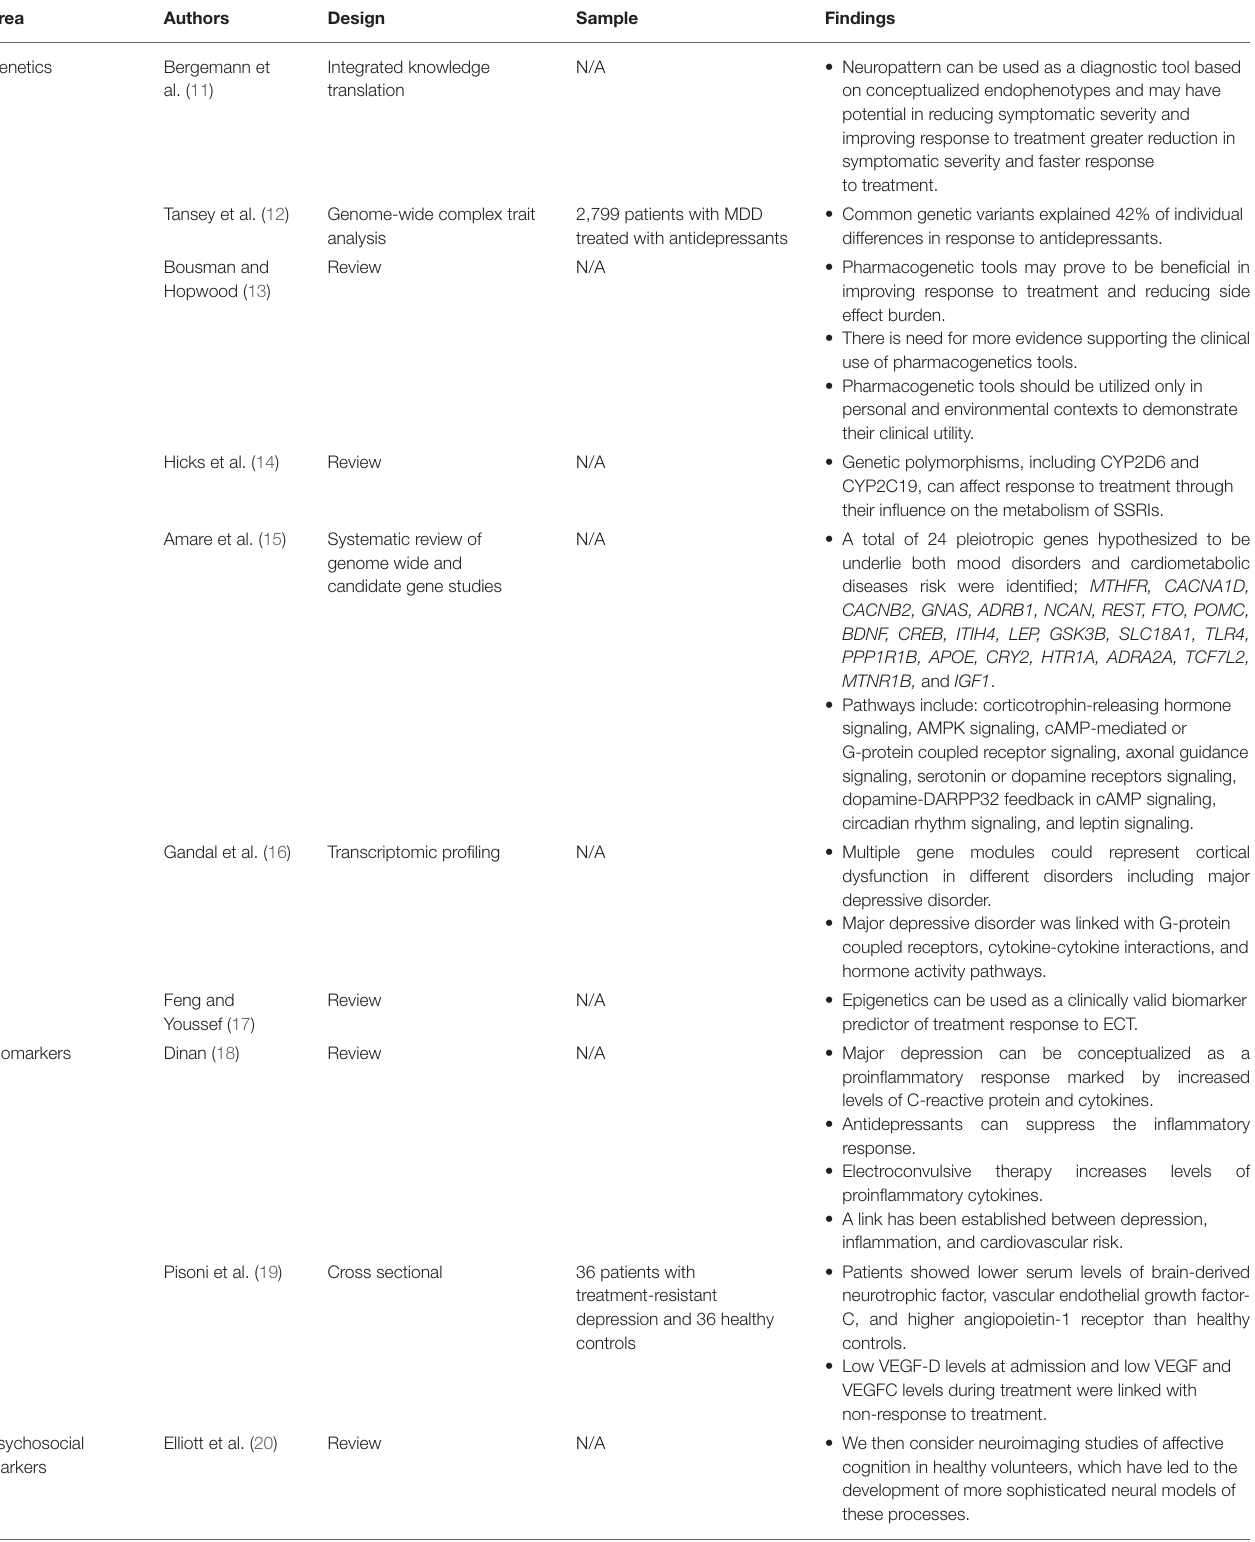
TABLE 1 | A summary of studies on genetics, biomarkers, psychosocial markers, and the treatment of major depressive disorder from a personalized perspective.